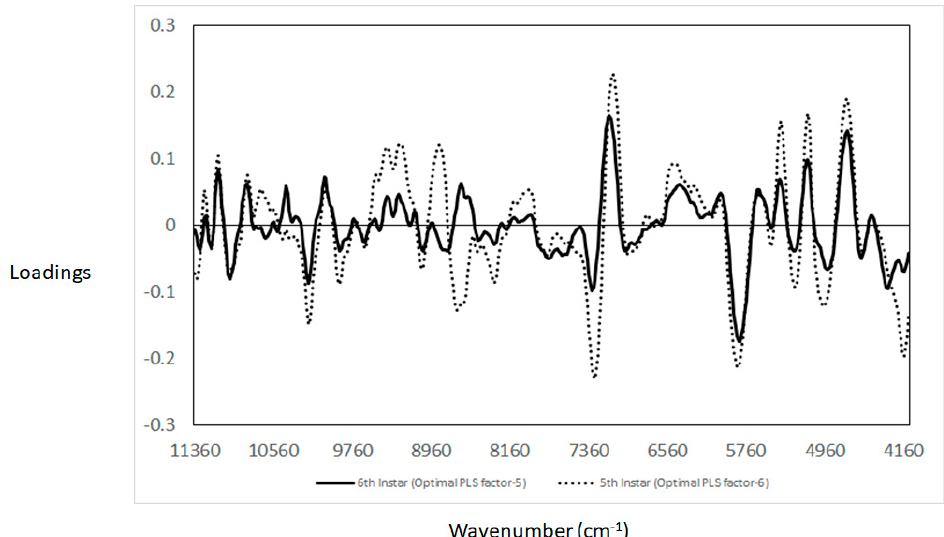
Figure 6. Partial least squares optimal loadings used to predict the source of stream feed utilised to rear the black soldier fly samples analysed using near infrared spectroscopy.